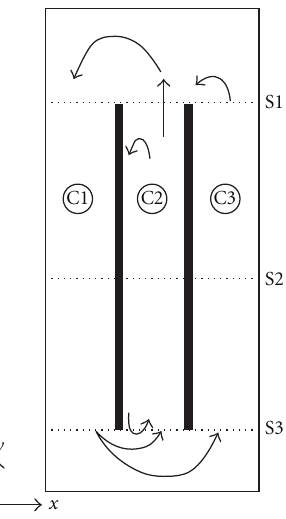
Figure 4: Schematic representation of the flow in Geometry